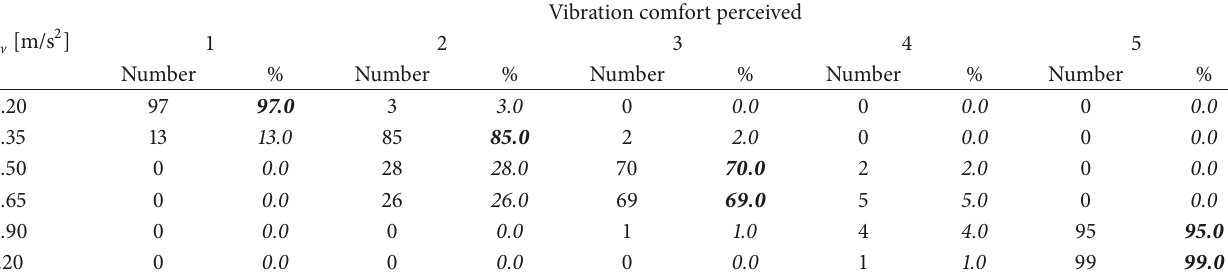
Table 2: Preliminary sample survey results to detect the perceived vibration level.